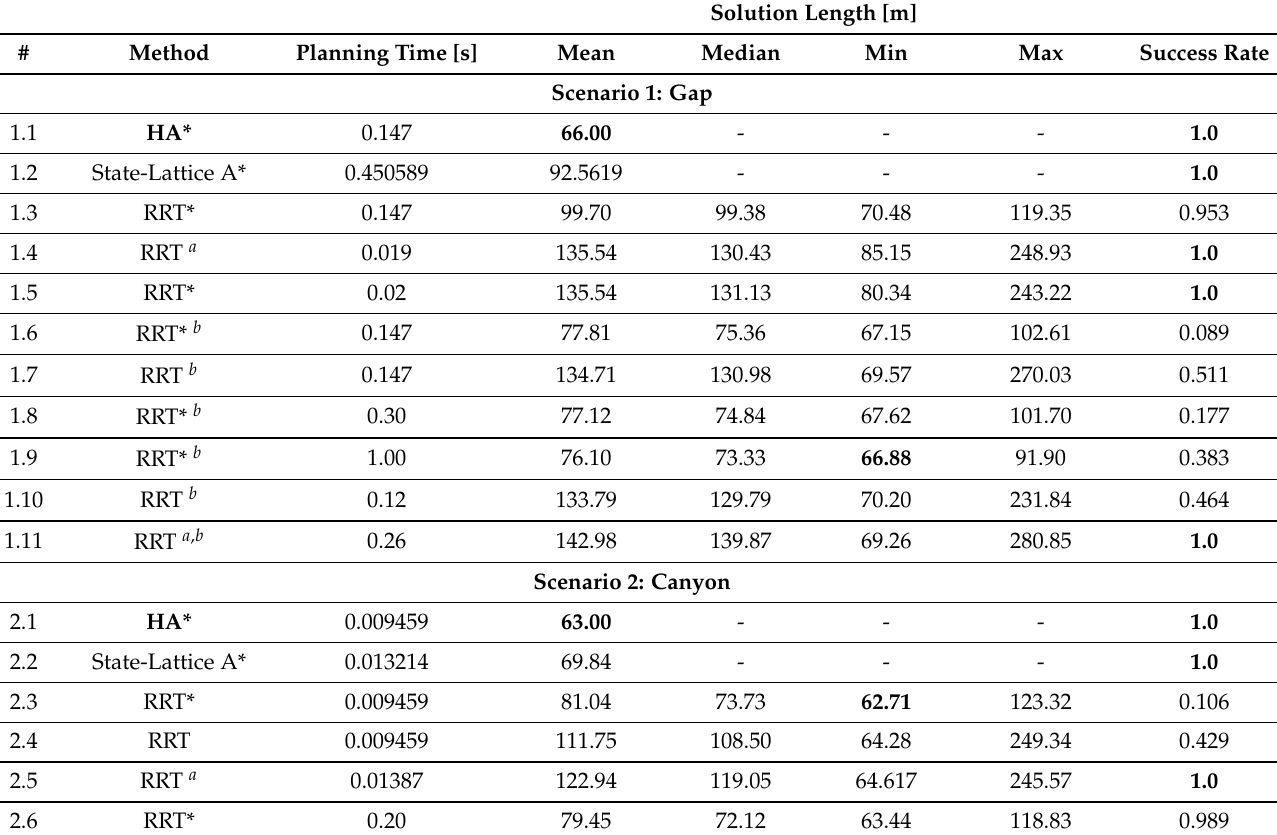
Table 2. Comparison between our presented HA*, state-lattice A*, RRT and RRT* with Dubins curves. The results for the sampling-based approaches are based on 1000 executions. b Sampling region forcing the path to go through the gap. a Planning time is the average time for RRT to find a solution, allowing planning until one is found in each